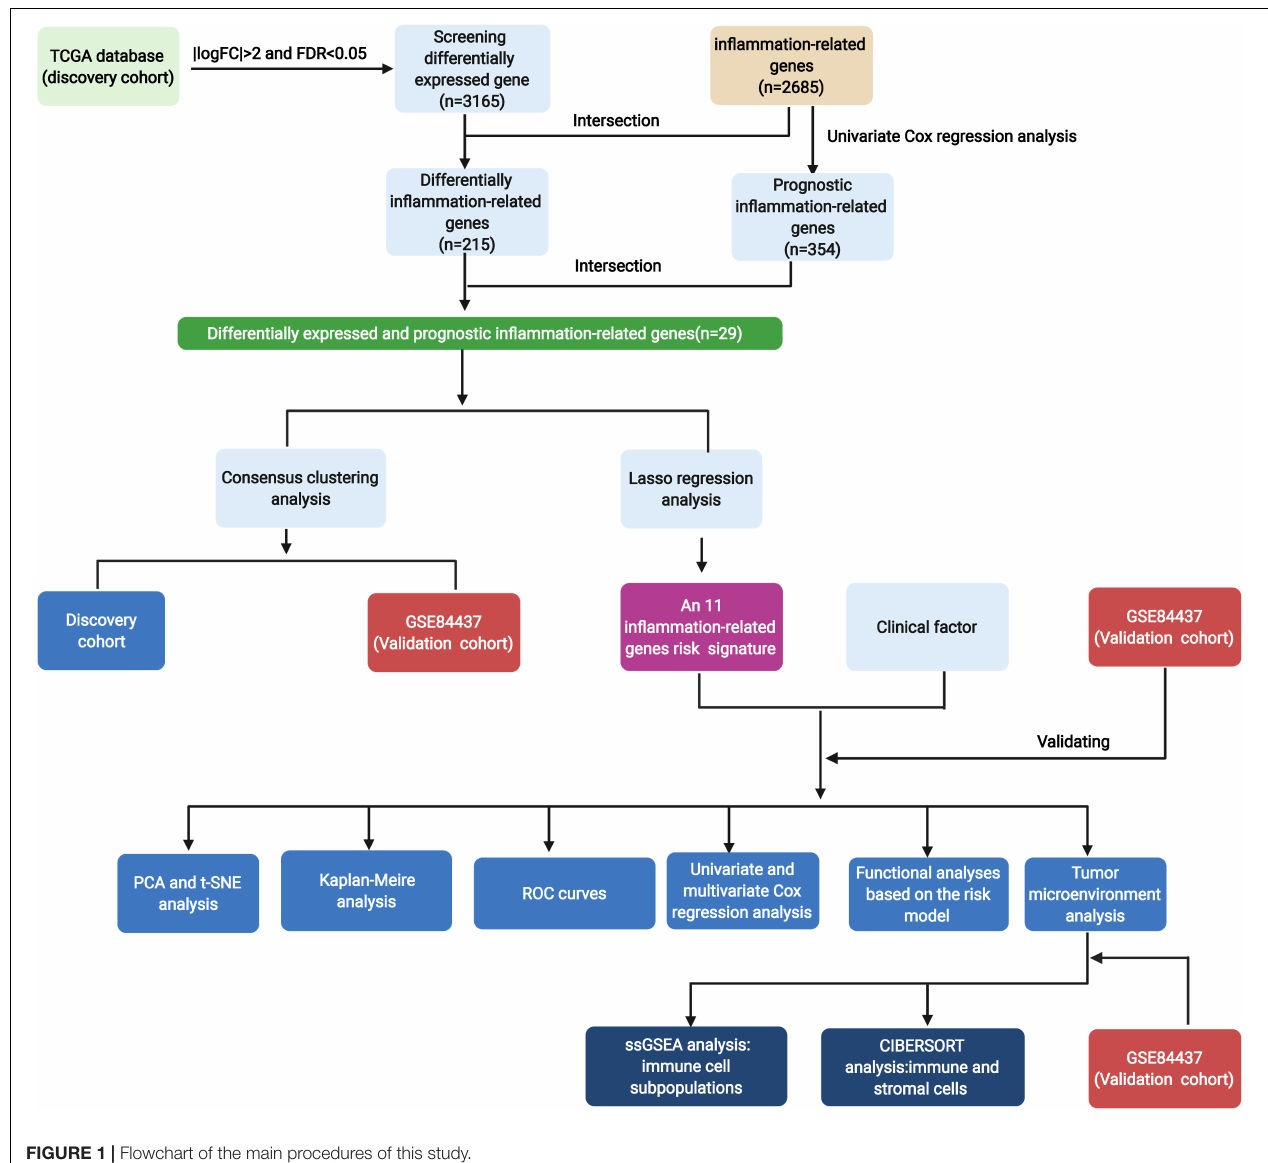
FIGURE 1 | Flowchart of the main procedures of this study.